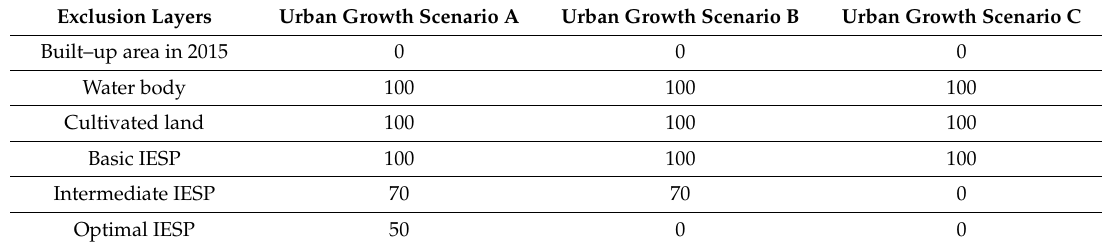
Table 4. Exclusion probability of the selected layers in the three urban growth scenarios (%).